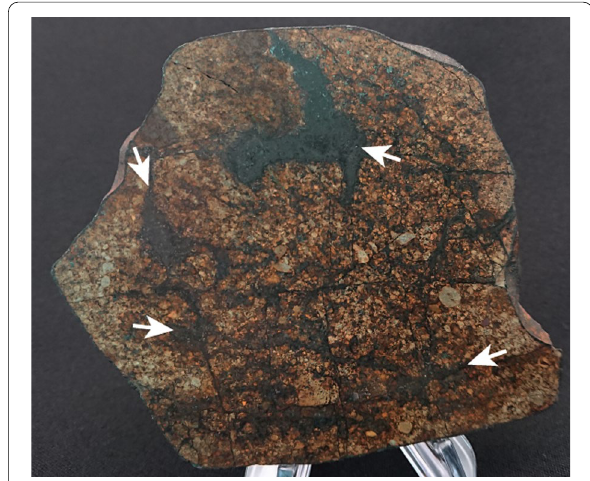
Fig. 1 A heavily shocked meteorite (The Monze L6 ordinary chondrite). Black-colored veins (white-colored arrows) are shock-melt veins